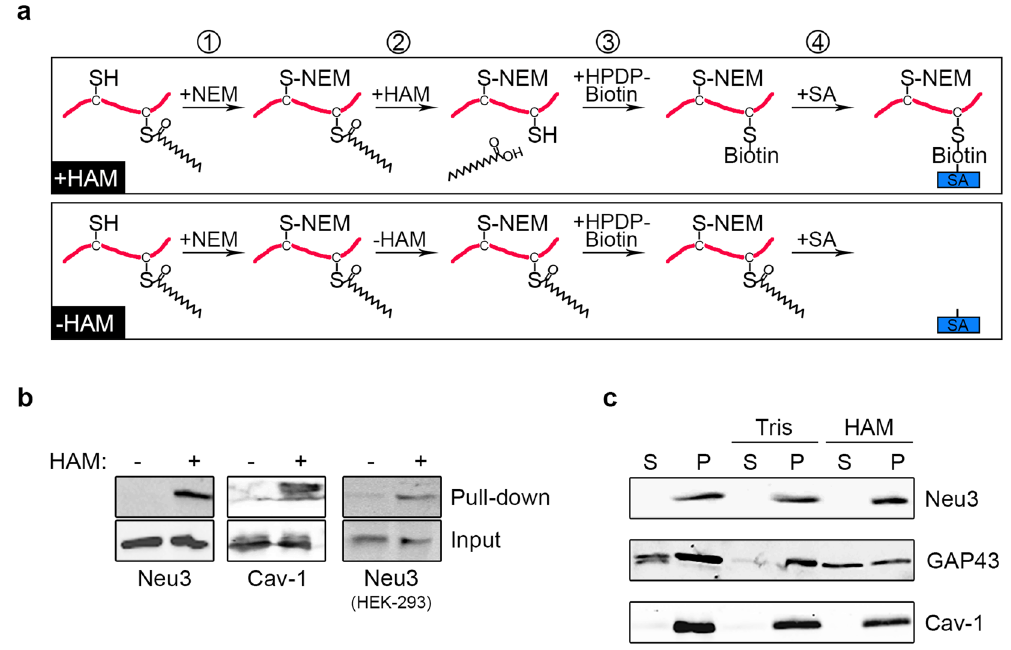
Figure 3. Neu3 is S-acylated. ( a ) A schematic diagram of the acyl-biotin exchange (ABE) assay. (1) Irreversible blockade of free thiol groups using N-ethylmaliemide (NEM); (2) Specific cleavage of thioester bonds and unmasking of acylated cysteines by hydroxylamine (HAM). In this step, omission of HAM served as a negative control; (3) Labeling of the S-acylated cysteines using the thiol-reactive biotinylation reagent HPDP-biotin; (4) Pull-down of the biotinylated proteins with streptavidin agarose beads (SA). ( b ) Cell lysates from NEU3 - transfected cells were subjected to ABE analysis. For the negative control, HAM was substituted by Tris buffer (-HAM). Cav-1 was used as a marker of a known S-acylated protein. Neu3 purified from HEK-293 cells was also subjected to ABE analysis. ( c ) Effect of HAM deacylation of Neu3 on its membrane association. Membrane fractions (P, second lane) were treated with Tris buffer (control) or with HAM. After treatment, membranes were collected by ultracentrifugation, and membrane-bound (P, fourth and sixth lanes) and solubilized (S, third and fifth lanes) proteins were analyzed by Western blotting using anti-Neu3 antibody. As the two covalently- bound fatty acids of GAP43 are directly involved in its membrane association, GAP43 was used as a marker of a protein released into the supernatant after treatment with HAM. Cav-1 was used as a marker of an S-acylated protein not released after HAM